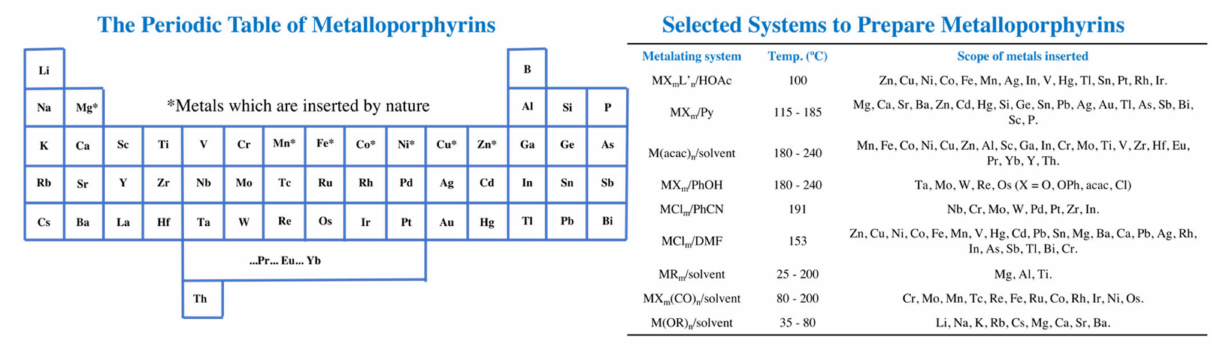
Figure 1. Periodic table of metalloporphyrins and metalating systems to prepare metalloporphyrins adapted from “The